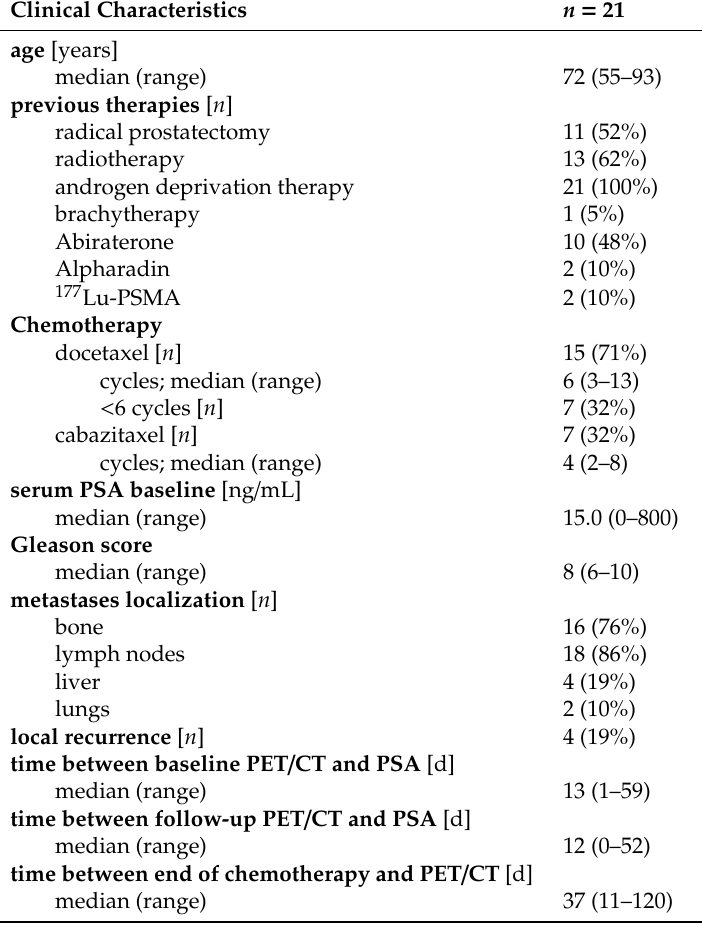
Table 1. Study cohort of n = 21 patients receiving chemotherapy for castration-resistant prostate cancer (CRPC). PSMA: prostate-specific membrane antigen; PSA: prostate-specific